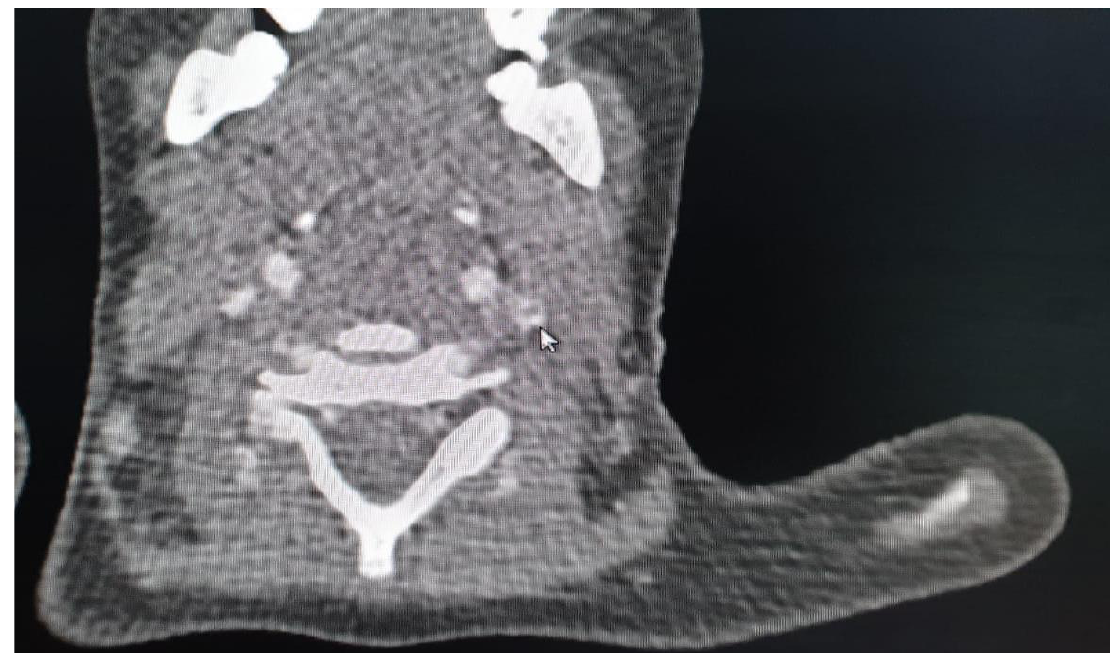
Figure 6. CT scan, right IJV thrombosis, calcifications in the trachea in the context of calciphylaxis.